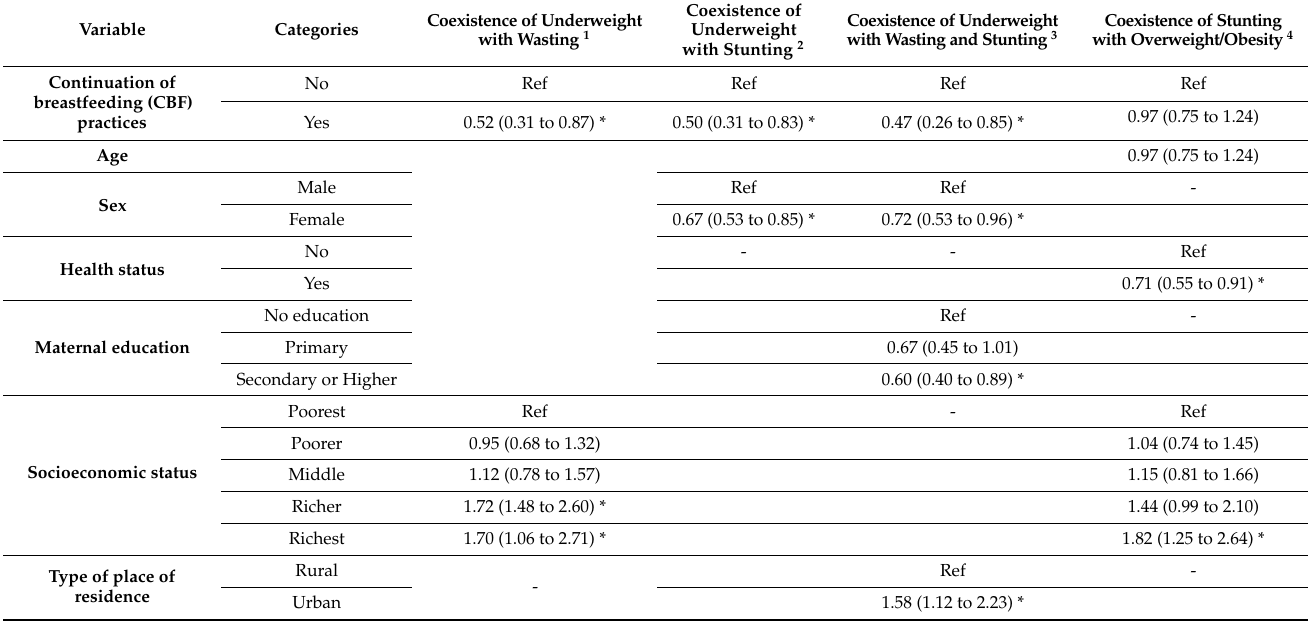
Table 2. Multinomial adjusted model for the associations between continuation of breastfeeding and CFM.